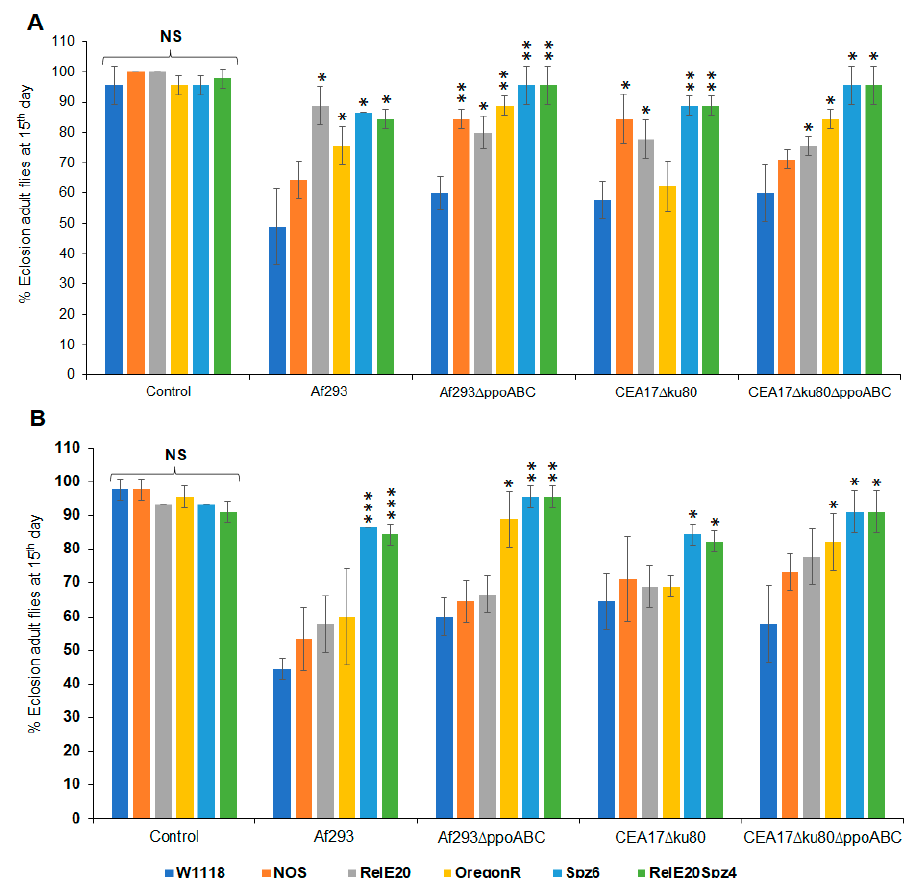
Figure 5. Comparative analyses of the white − eyed and red − eyed Drosophila male adults exposed to VOCs emitted from four different A. fumigatus strains. Percentages of eclosion adult flies exposed to VOCs emitted by Af293, Af293 ∆ ppoABC , CEA17 ∆ ku80 , and CEA17 ∆ ku80 ∆ ppoABC pre − grown at 25 ◦ C for 5 days are shown in ( A ); at 37 ◦ C for 3 days are shown in ( B ). * Represents the significant differences between different treatments, where 0.005 < * p < 0.05, 0.0005 < ** p < 0.005, *** p < 0.0005; NS, p > 0.05.